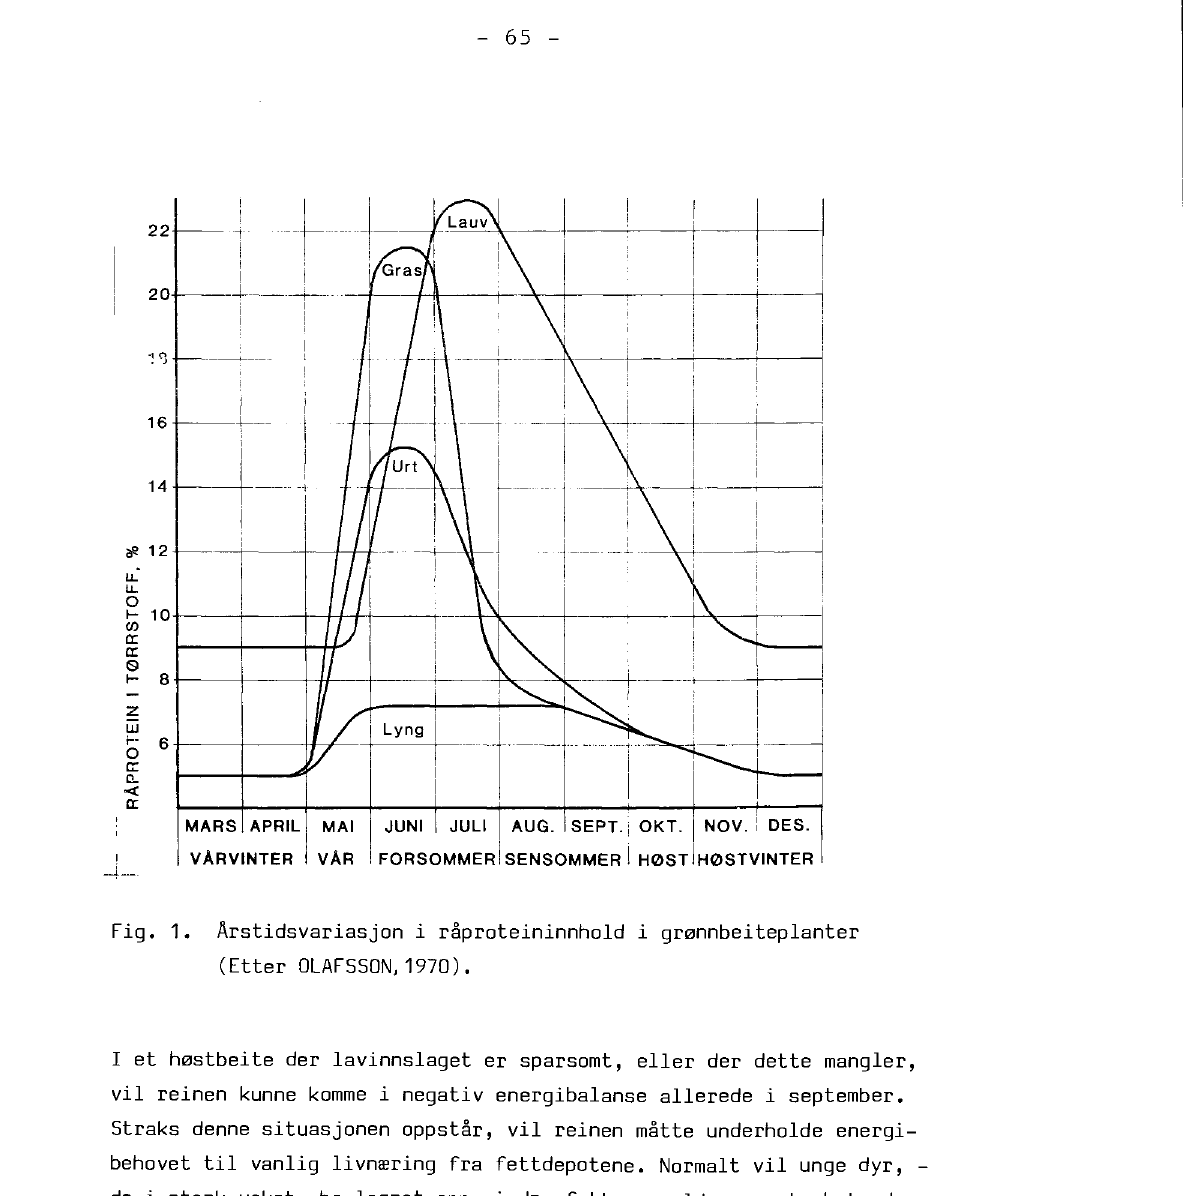
Fig. 1. Årstidsvariasjon i råproteininnhold i grønnbeiteplanter (Etter